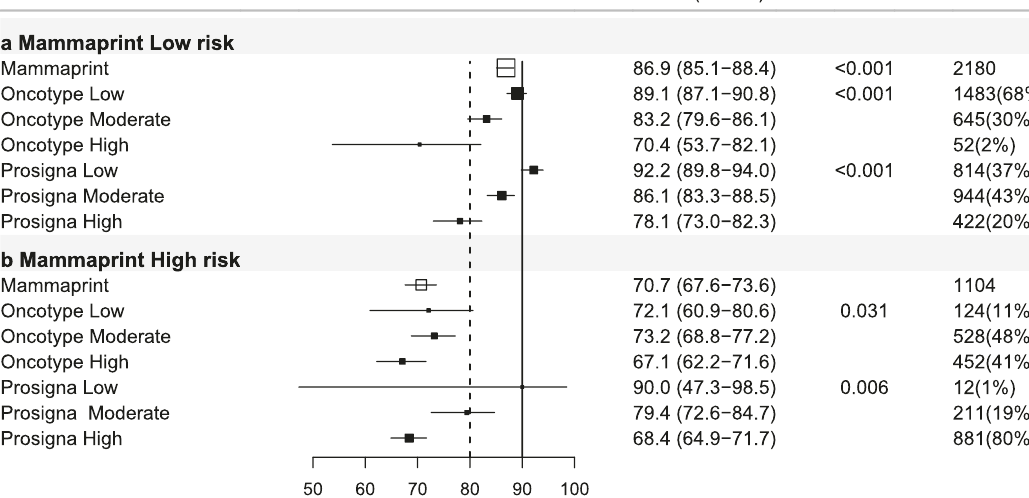
Fig. 4 Forest plot of Mammaprint-trained test results re-strati fi ed by other tests, all ER + ve/HER2-ve cases. DMFS10 = distant metastasis free survival at 10 years post diagnosis. (95% CI) = 95% con fi dence interval, P = p value, N = number of cases in each subgroup, % = percentage of cases within each risk strata, X axis = percent distant metastasis free survival. Open boxes represent primary test DMFS10 by risk group. Solid boxes represent sub-strati fi cation by secondary tests with 95% con fi dence intervals (bars). Top panel ( a ) Mammaprint-trained low-risk cases strati fi ed by Oncotype-trained and Prosigna-trained results. Bottom panel ( b ) Mammaprint-trained high-risk